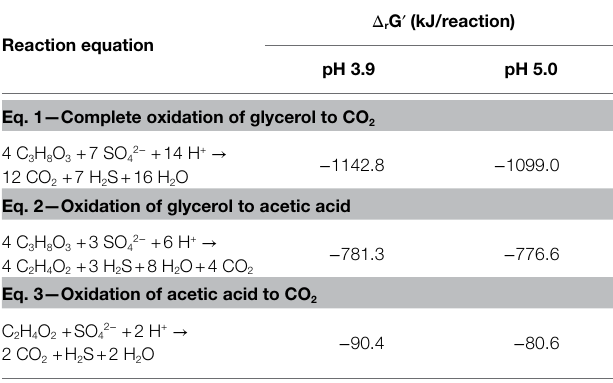
TABLE 4 | Gibbs free energy of complete and incomplete oxidation of glycerol to CO 2 and acetic acid,